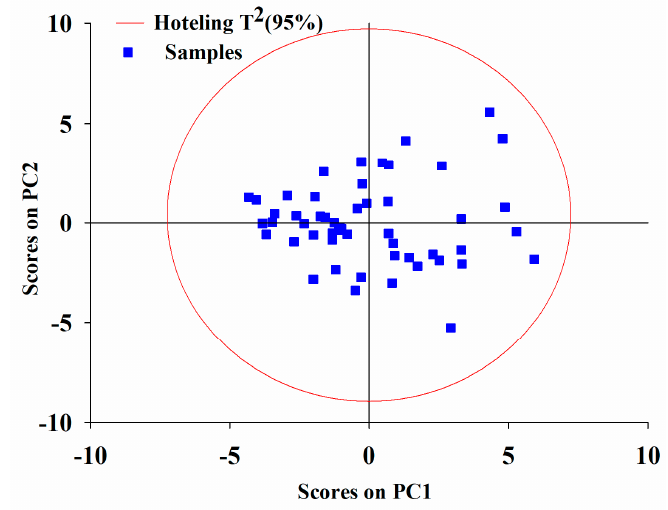
Figure 4. Score plot with the first two principal components (PCs) model for all available